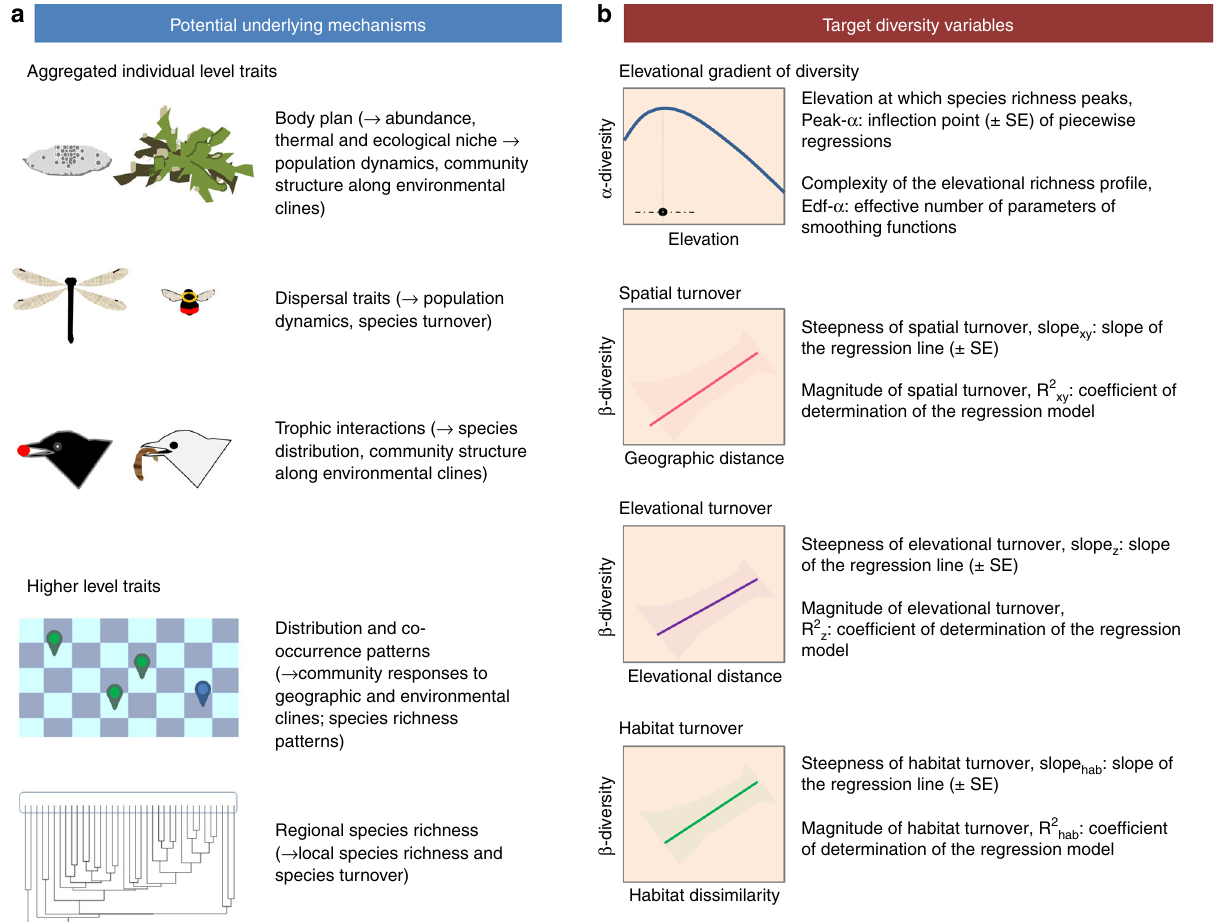
Fig. 1 Graphical representation of diversity – environment relationships and the organismal and higher-level features that may in fl uence them. a The intrinsic features and the mechanisms through which these features might in fl uence diversity variables. b The eight target responses (diversity variables) estimated for each of the four diversity – environment relationships and confamilial